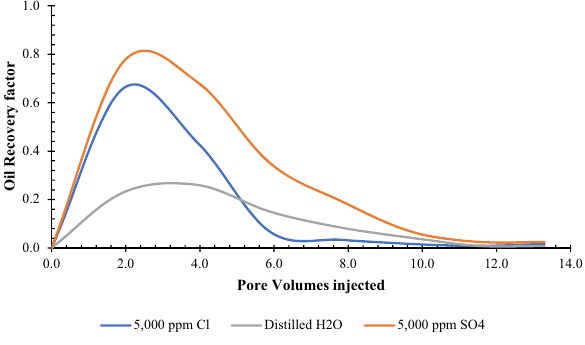
Fig. 13 Evaluation of displacement efficiencies of all the brines used in the experiment